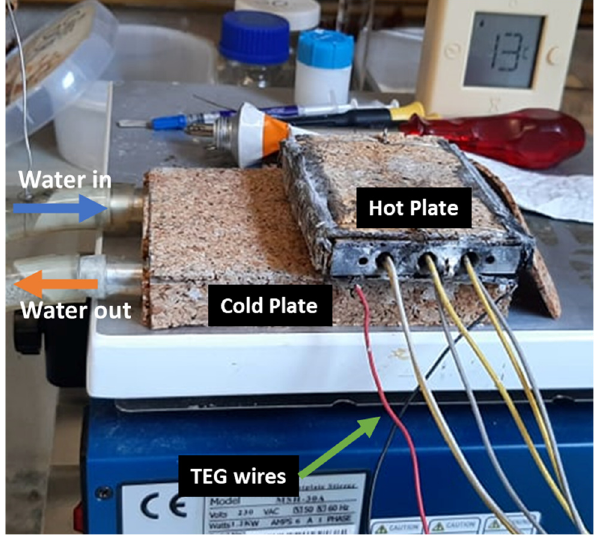
Figure 1. Experimental set up.